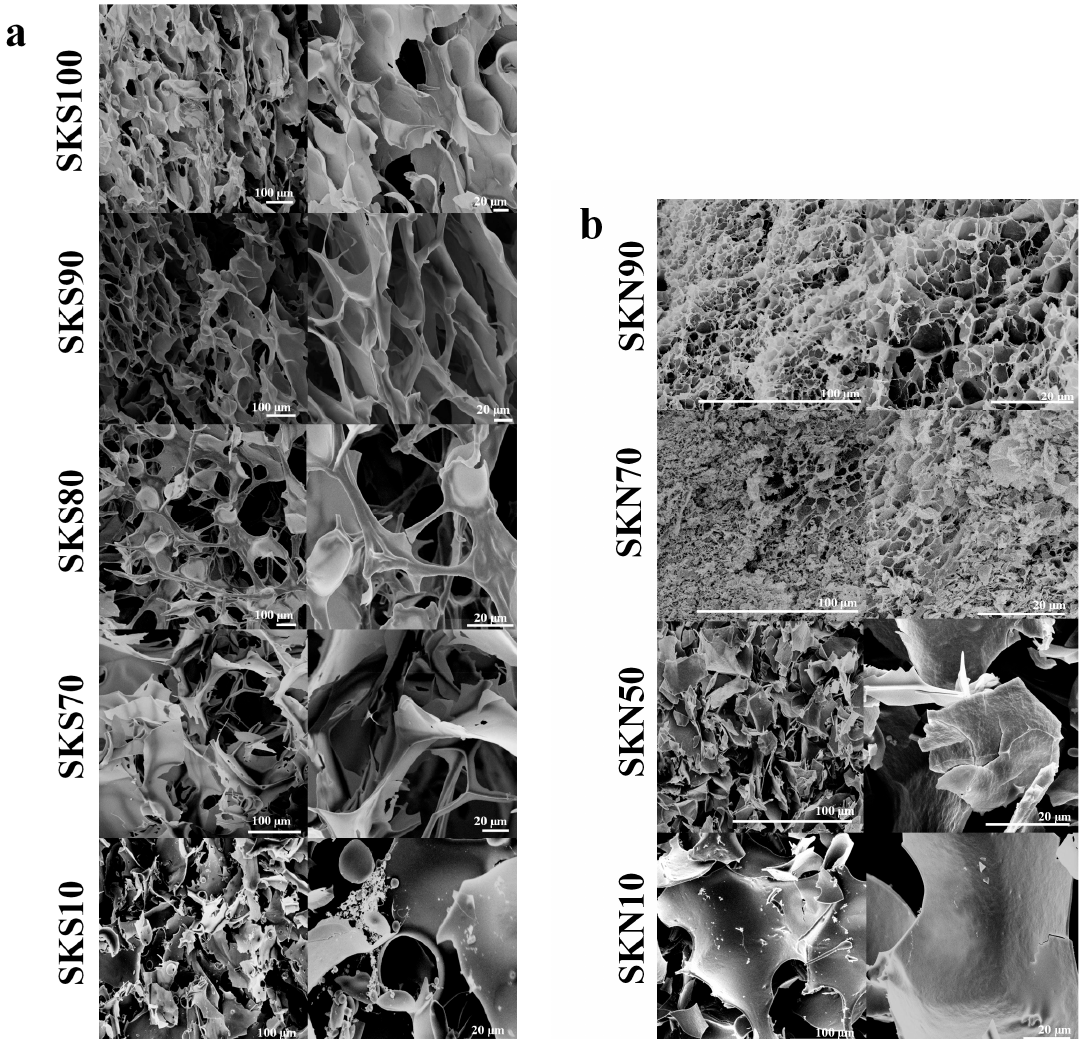
Figure 2. SEM images of various silk-keratin samples: ( a ) ultrasonication-induced hydrogel/ aggregate scaffolds (with various silk fibroin composition of 100, 90, 80, 70, and 10 wt % ); ( b ) naturally-self-assembled hydrogel/aggregate scaffolds (with various silk fibroin composition of 90, 70, 50, and 10 wt % ). All samples are displayed at two scales: 100 and 20 μ m.